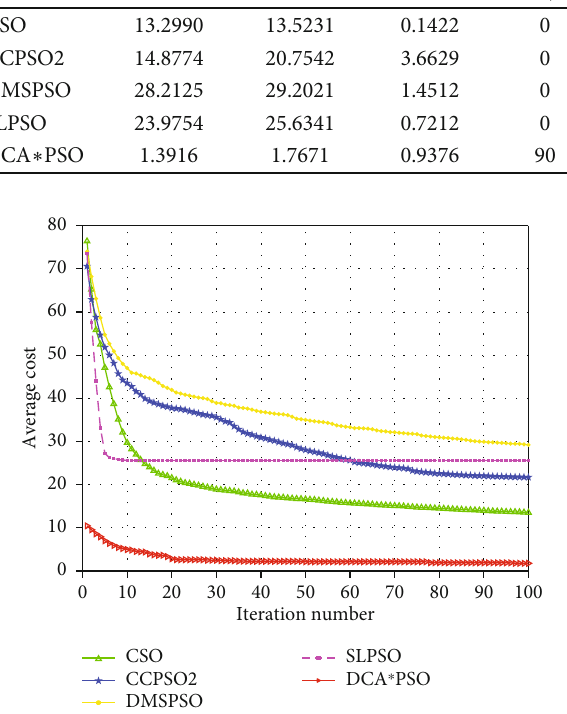
Figure 11: The average cost of di ff erent algorithms in case